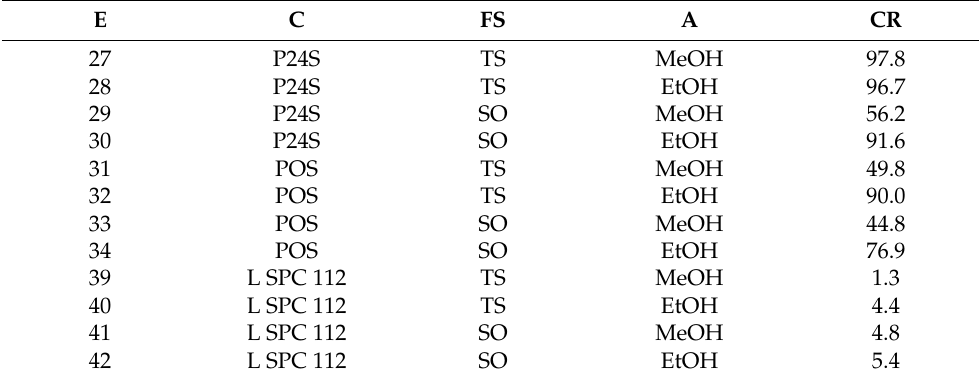
Table 11. Study of other catalysts and fatty matrix in optimal condition.